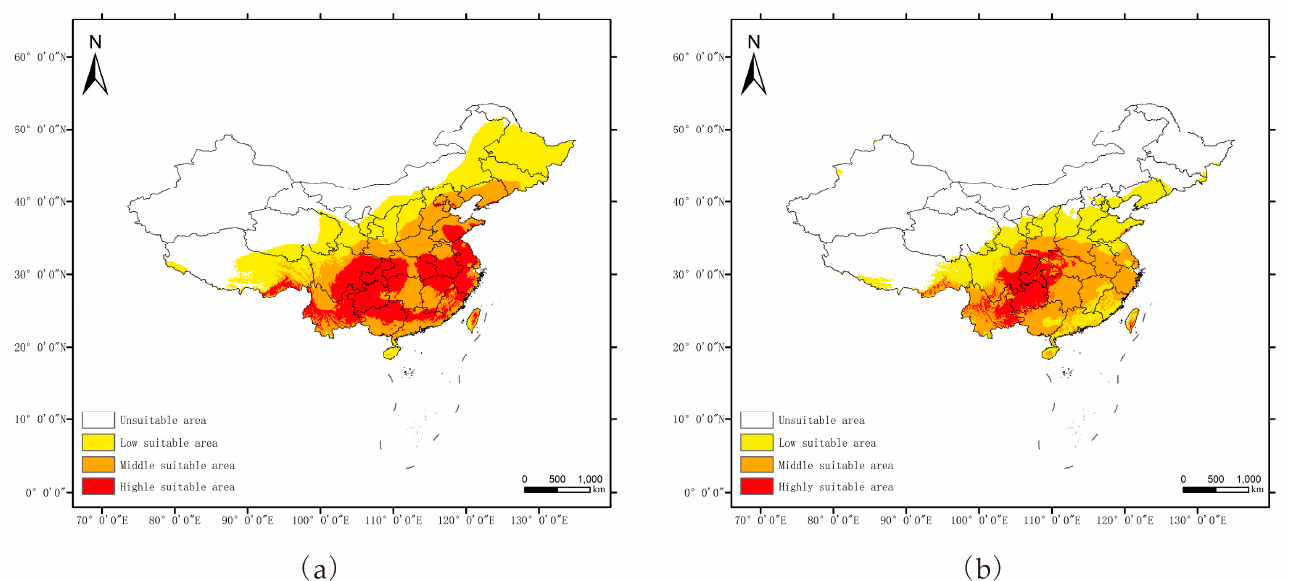
Figure 6. Potential distribution of P. salicina ( a ) and M. fructicola ( b ) in China. However, there was a smaller, highly suitable area for M. fructicola , which was mainly located in the Yunguichuan Plateau and Chongqing (Figure 6b). The other areas of southern China were marked as moderately suitable for M. fructicola , including Henan, Jiangxi, Jiangsu, Zhejiang, Hunan, Guangxi, and Anhui (Figure 6b). There was a 58.96 × 104 km 2 area marked as highly suitable for M. fructicola . Its total suitable area covered 382.63 × 104 km 2 , accounting for 6.12% and 39.71% of China’s land area (Figure 6b),